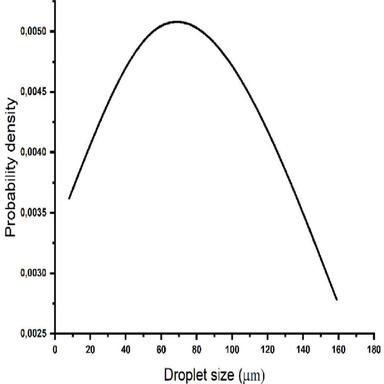
The Gaussian distribution curve for the Al-Mo suspension. Note that the Inner tip size: 1.01 mm / Outer tip size: 1.52 mm, the feed rate of the suspension: 5.00 ml/min, the pressure of argon plasma gas: 50.00 PSI, and the carrier gas flow: 80.00 mm are the set of parameters employed to atomize the suspension and obtain the droplets.